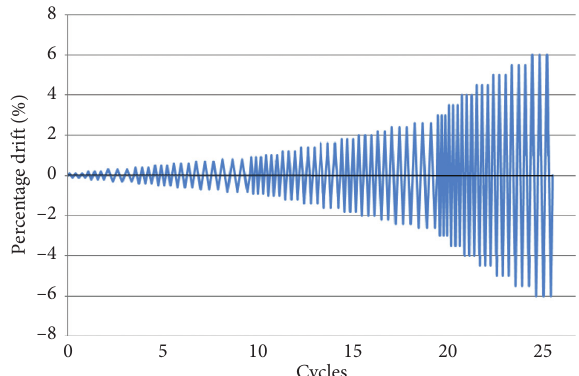
Figure 11: Loading history.